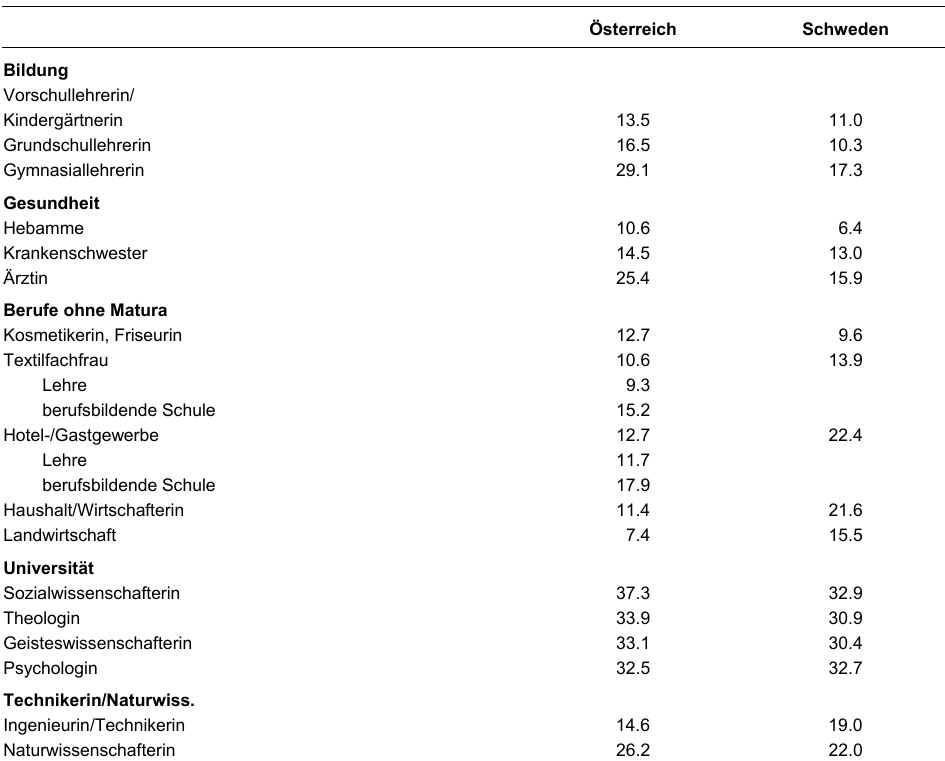
Tabelle 1: Kinderlosigkeit von Frauen in ausgewählten Bildungsrichtungen